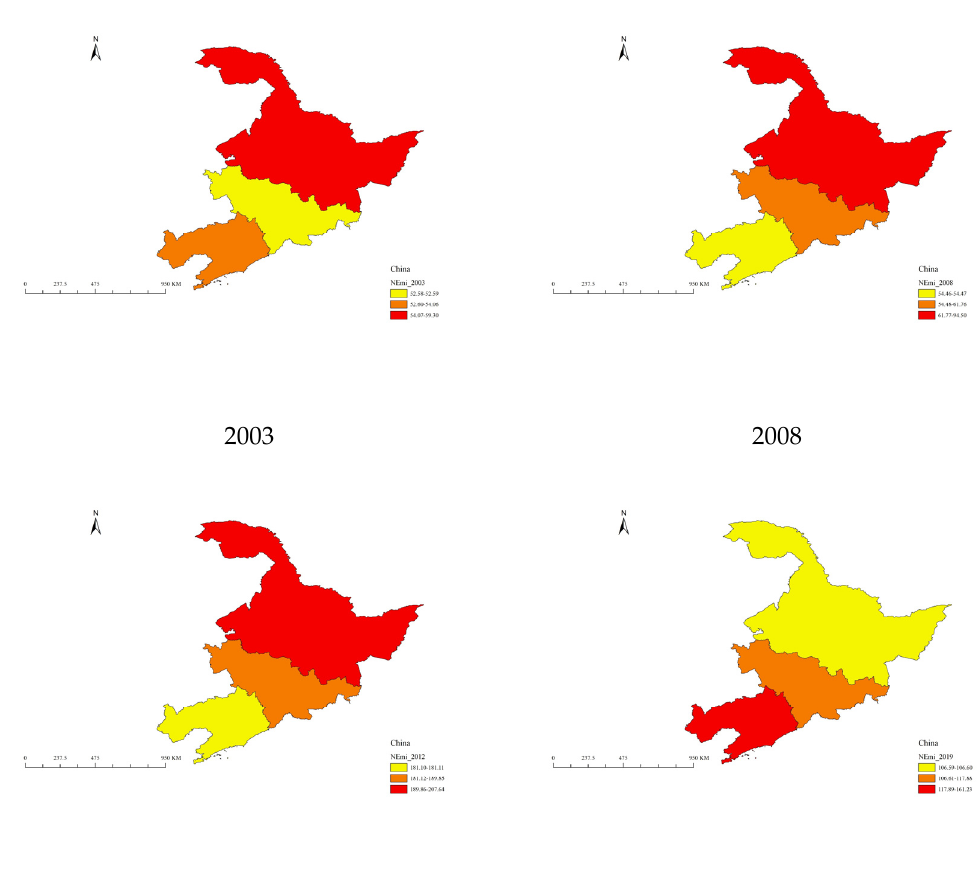
Figure 5. The level of market integration in Northeastern China.